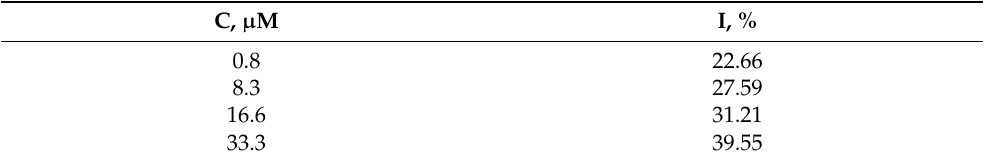
Table 5. EC 50 ( µ M) and degree of inhibition (I, %) of LOX 1-B lipoxygenase in the presence of compound 2 .